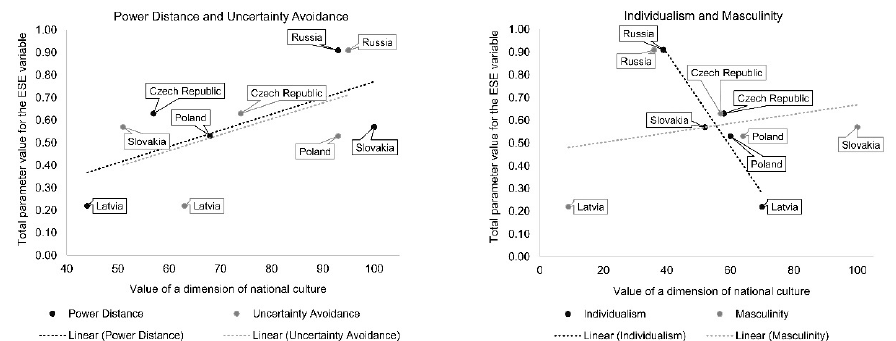
Figure 2. The relationship between the entrepreneurial self-efficacy variable and the values character- ising the countries in question in terms of the cultural